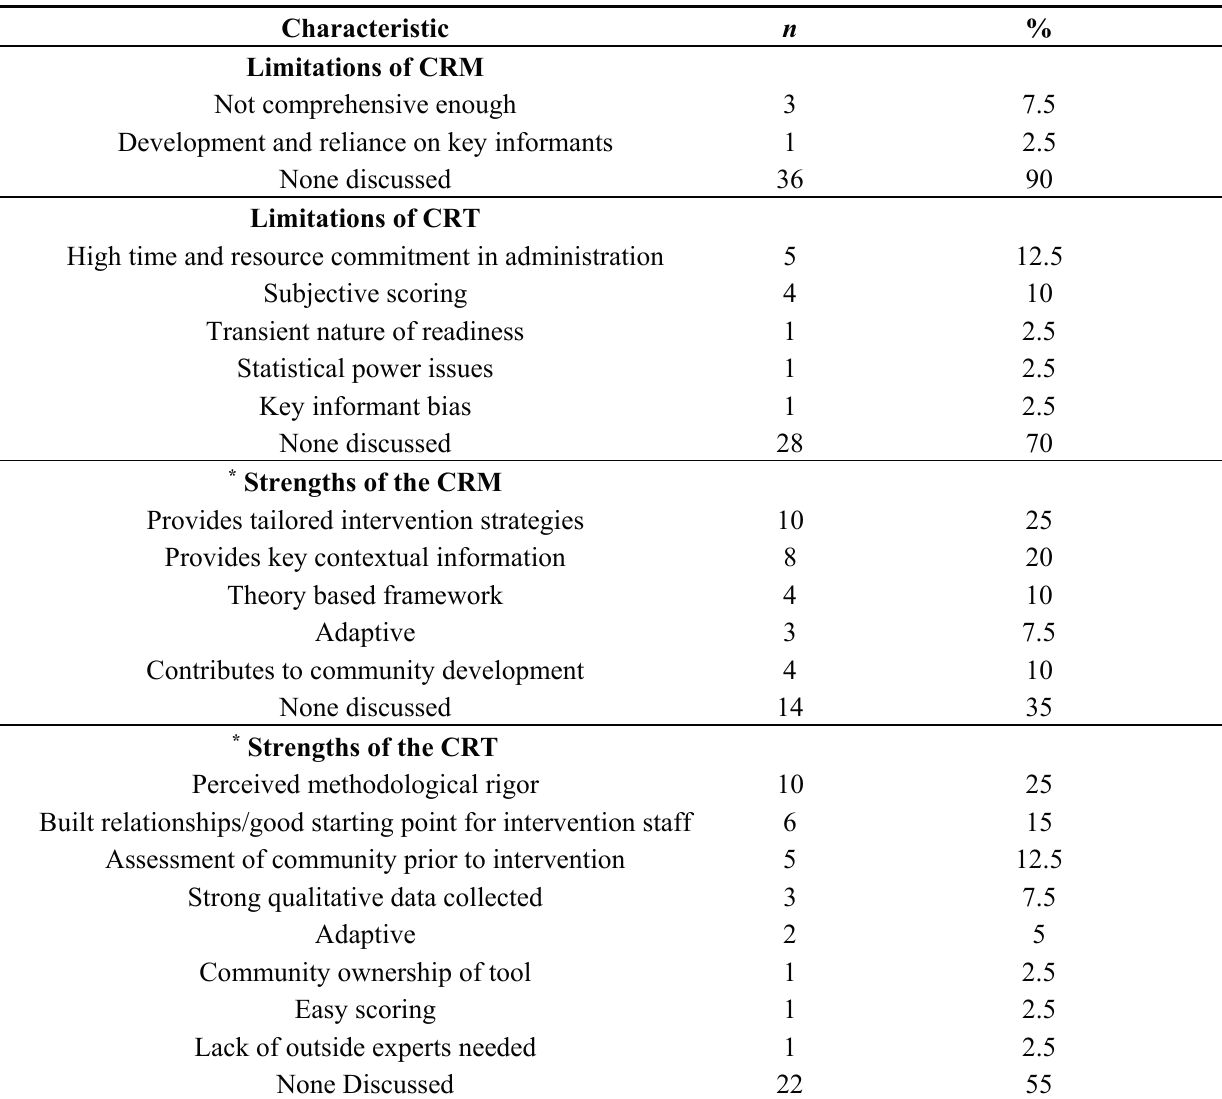
Table 2. Limitations and strengths of the community readiness model (CRM) and community readiness tool (CRT) as discussed by the studies included in this review ( n =